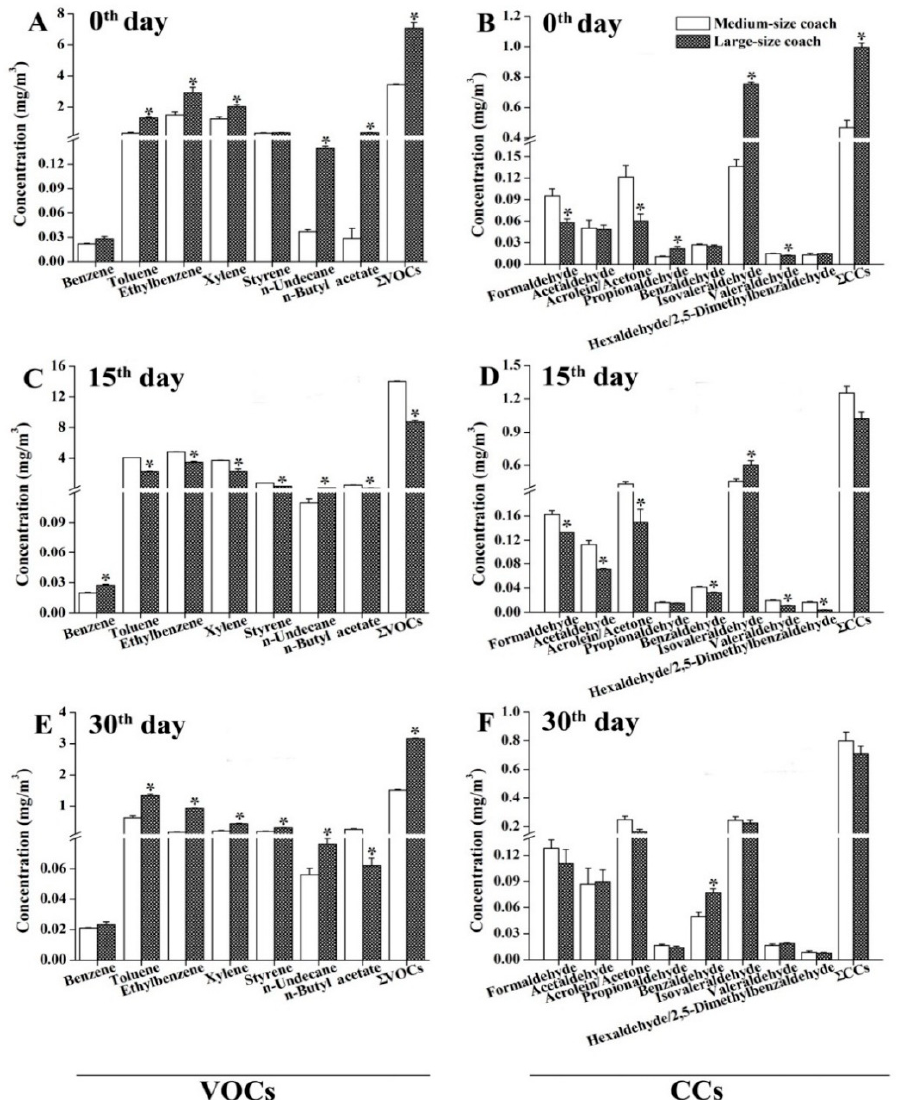
Figure 4. Comparison of the emission characteristics for organic compounds between the medium- and large-size air-conditioned coaches. Air samples were collected on the 0th, 15th, and 30th day after coming off the assembly line, respectively. Interior temperature: 25 ± 2 °C. Interior relative humidity: 50% ± 10%. ( A , C , E ) Levels of VOCs in the tested air samples; ( B , D , F ) Levels of CCs in the tested air samples. The results are expressed as the mean ± SEM. *: p < 0.05, medium-size coaches vs. large-size coaches.